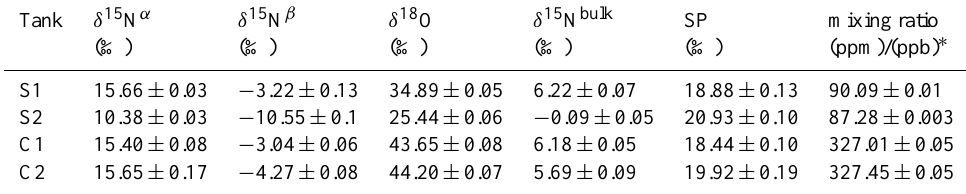
Table 1. Reference gas and compressed air tanks used during the campaign. S1 and S2 represent the anchor and calibration standard. C1 and C2 are the target gases used for determination of system performance. The reported precision is 1 σ